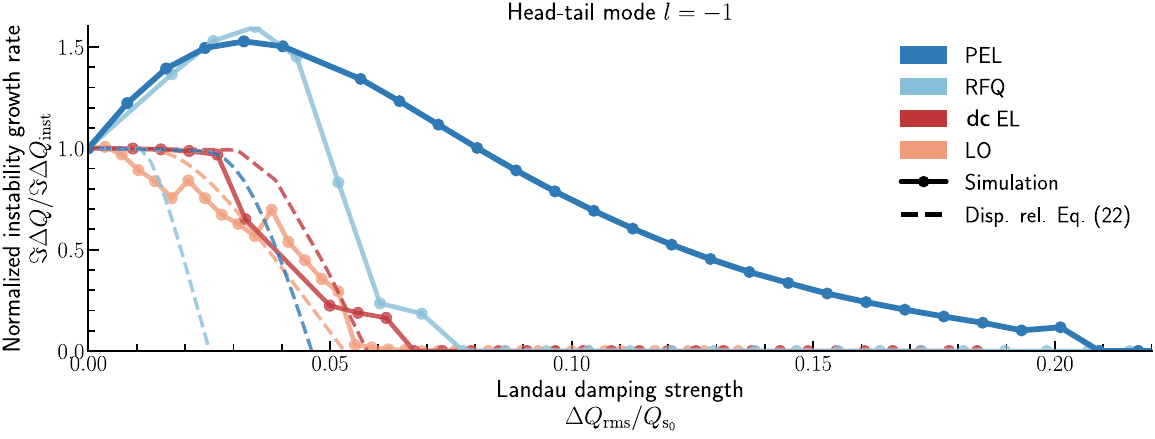
=Q forhead-tail mode l ¼ − 1 . A PEL(dark-blue), rms s 0